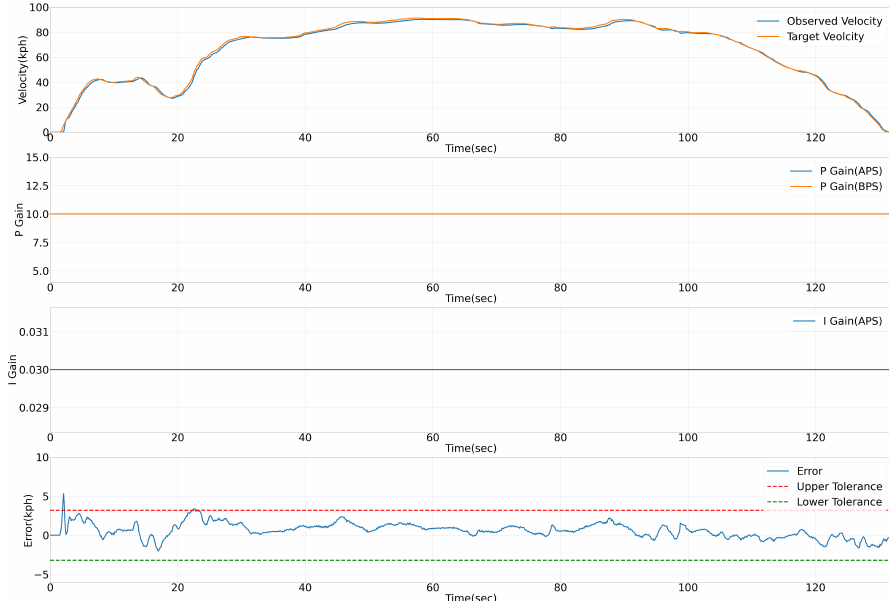
Figure 17. Test Results of the Fixed Gain Method in Eco Mode.